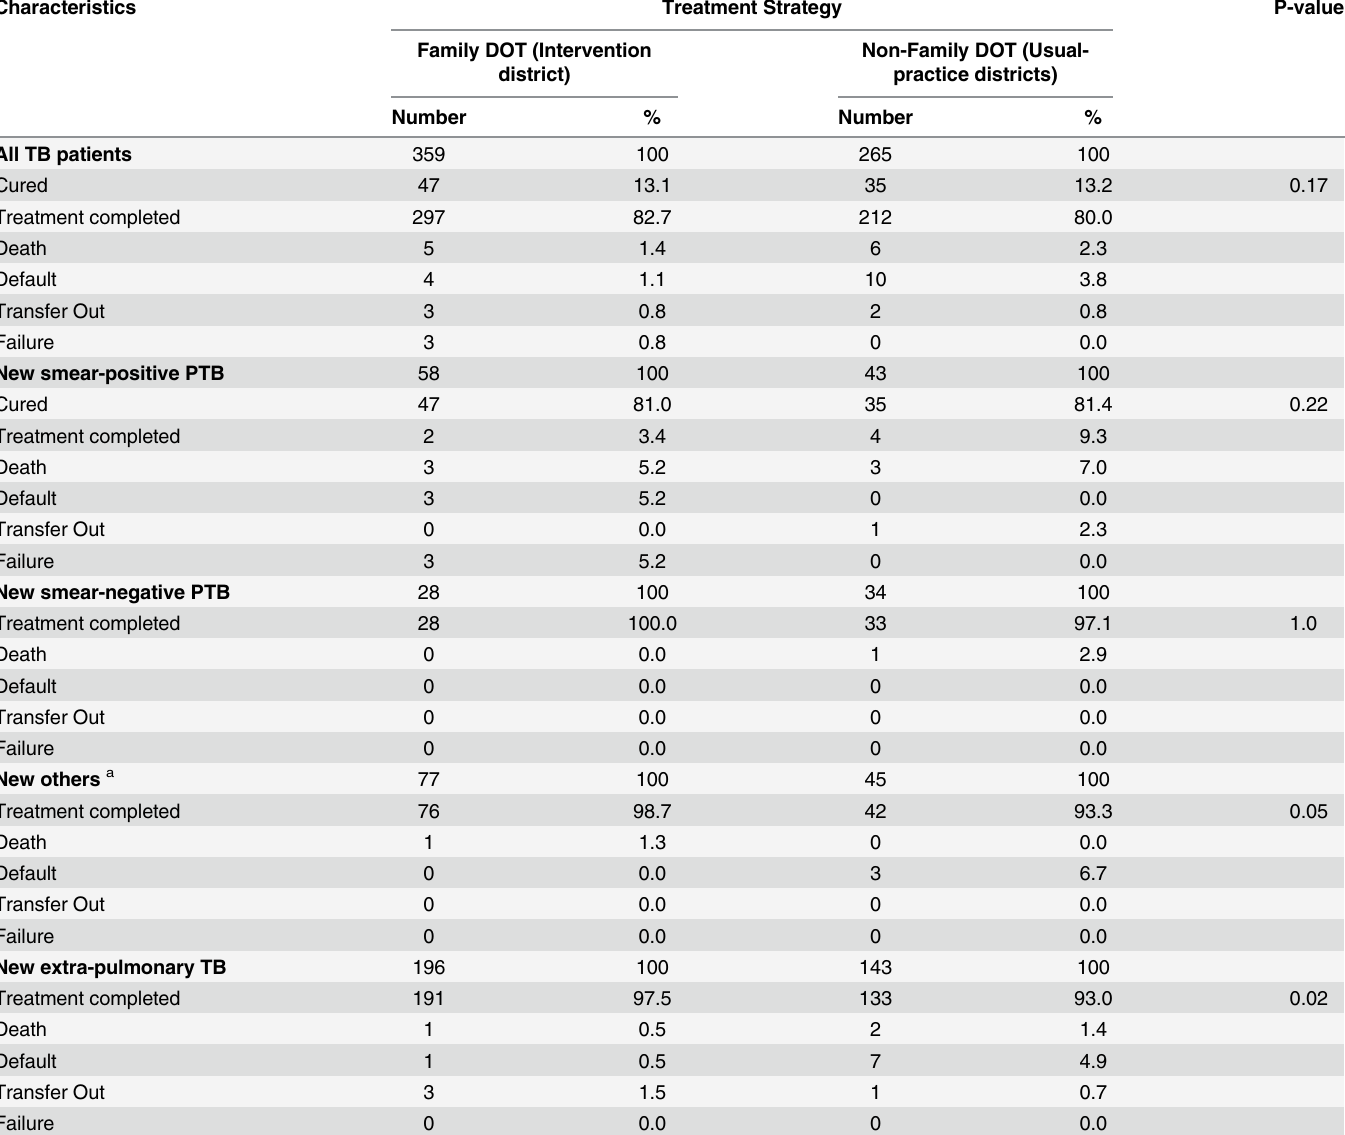
Table 3. Comparison of treatment outcomes among children with newly diagnosed TB, stratified by disease classification and treatment strategy, registered in Gujarat State, India, June-September 2012.